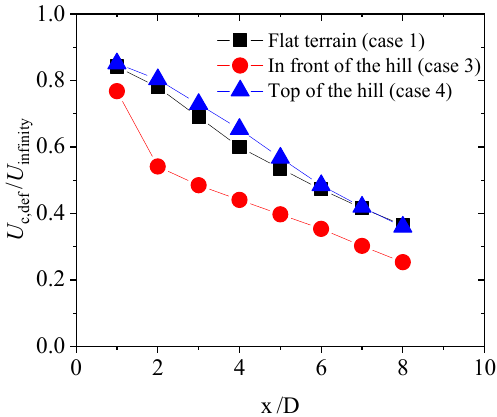
Figure 14. Comparison of mean velocity deficit on the wake center.